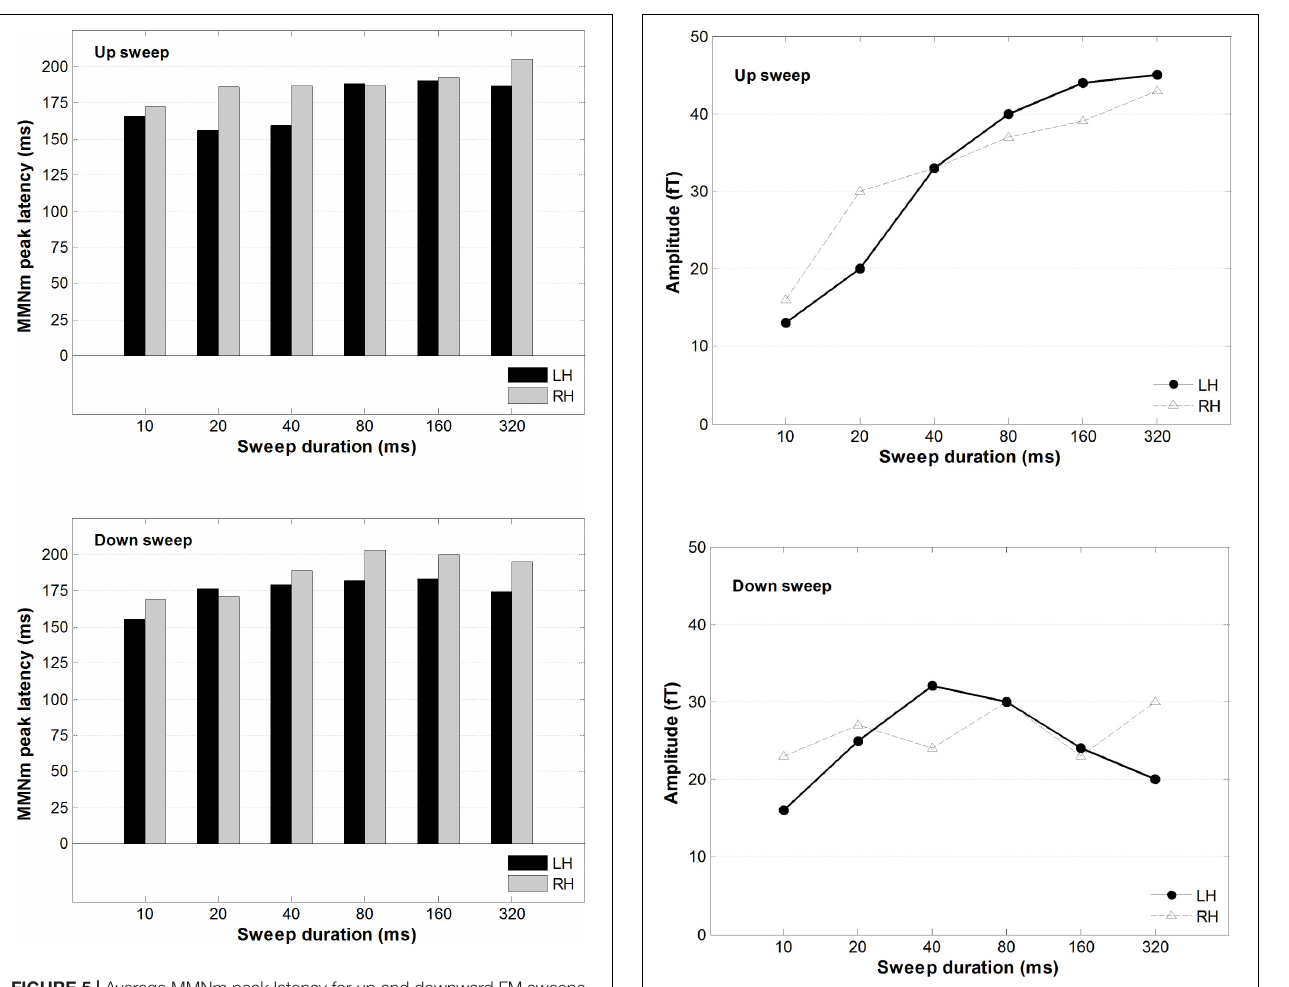
FIGURE 5 | Average MMNm peak latency for up and downward FM sweeps as a function of sweep duration. Black and gray bars represent peak latency for left and right hemisphere, respectively. No hemispheric difference was observed in the MMNm latency for both upward and downward FM sweeps.